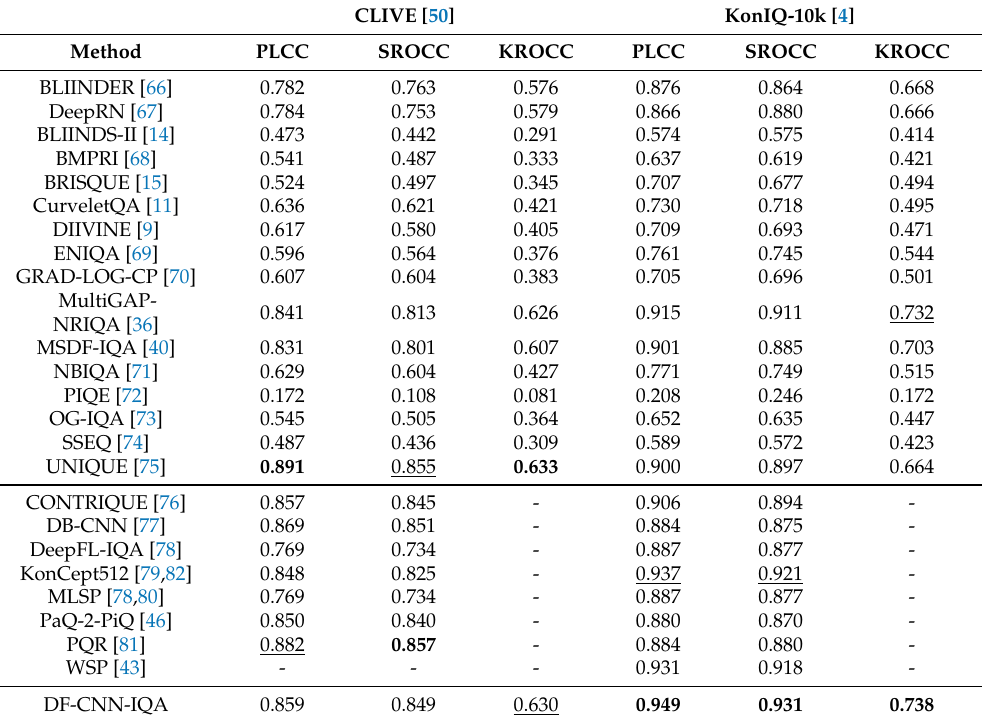
Table 4. Comparison of DF-CNN-IQA to the state of the art on CLIVE [50] and KonIQ-10k [4]. Median PLCC, SROCC and KROCC values were measured over 100 random train–validation–test splits. The best results are typed in bold , and the second-best results are underlined. We denoted by ‘-’ if the data was not